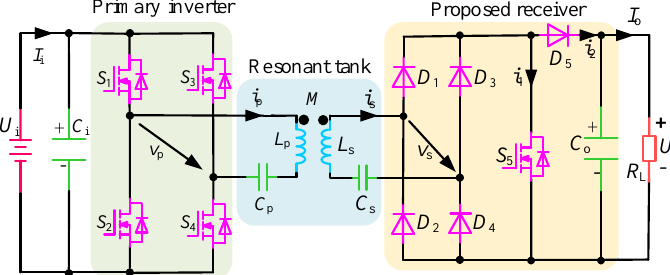
Figure 1. WPT system with proposed single-switch receiver.